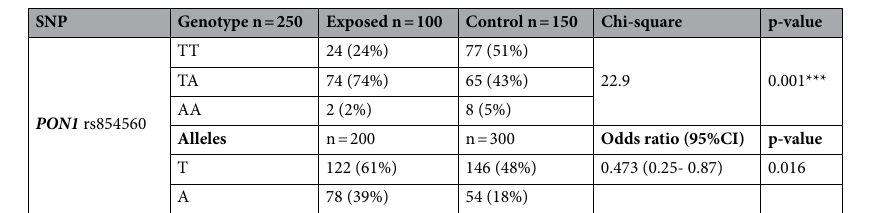
Table 1. Genotypic and allelic freuencies of PON1 rs854560 in study subjects with OPs and PYR pesticide toxicity. Significance p < 0.05.